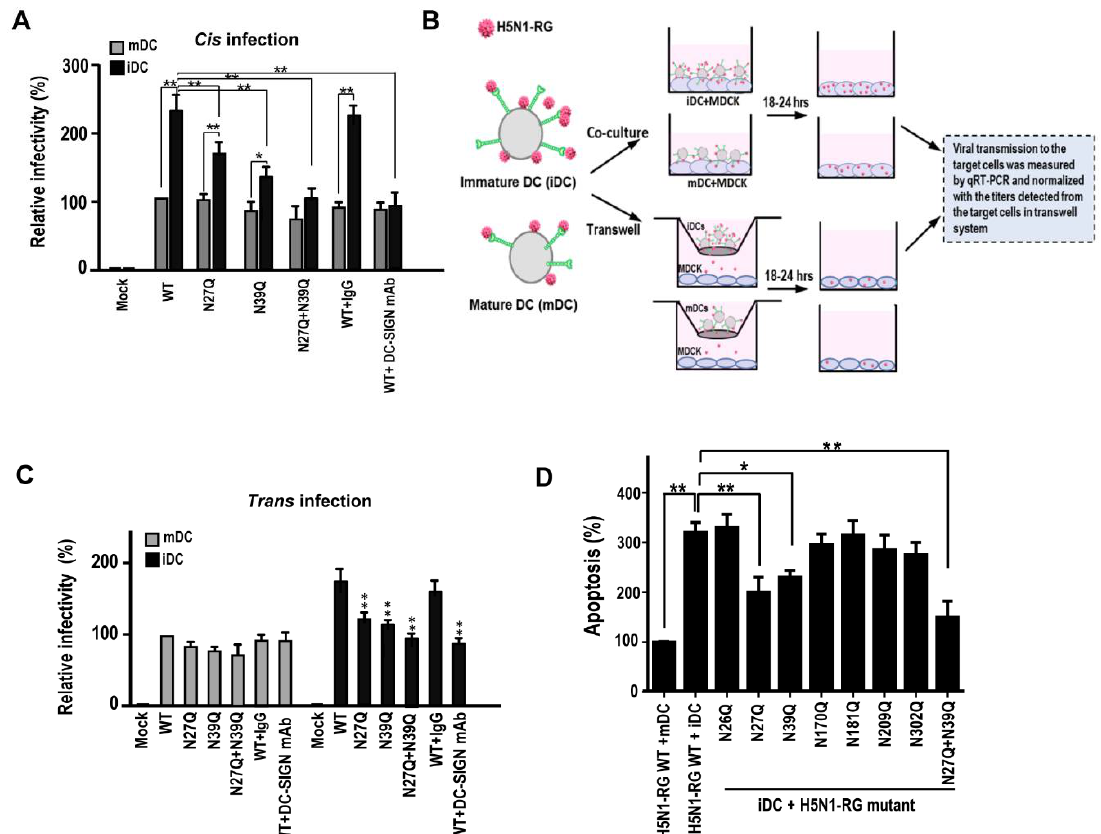
Figure 7. Mutation of 27 and 39 N-glycosylation sites ameliorate DC-SIGN mediated infection in cis and in trans. ( A ) The monocyte derived immature and mature dendritic cells (iDCs and mDCs) were infected with H5N1-RG viruses carrying different N-glycosylation mutations on HA at 37 °C for 48 h and subjected to qRT-PCR analysis. The relative infectivity was determined by viral copies detected in each group and normalized to wild-type virus infected iDCs. ( B ) The scheme of modified conventional capture assay is demonstrated. ( C ) iDCs and mDCs, as the capture cells, were incubated with H5N1-RG viruses carrying different N-glycosylation mutations on HA at 4 °C for 2 h and subjected to co-culture with MDCK cells (target cells) at 37 °C for 18–24 h. After co-culturing, the virions-captured cells (iDCs and mDCs) were removed via of intensive PBS washing (three to five times) and the MDCK cells were subjected to qRT-PCR analysis. The transwell system was used to monitor the virions budding from cis infection (the virions released from captured cells (iDCs and mDCs) are on the upper channel) and further caused MDCK (target cells) (lower channel) infection. The lower channel of MDCK cells receiving the virions from cis infection were also subjected to qRT-PCR. The relative infectivity was determined by using the viral copies detected from co-cultured MDCK and normalized with viral copies of MDCK from transwell system. ( D ) The iDCs and mDCs were infected with H5N1-RG wild-type or N-glycosylation mutants and incubated at 37 °C for 48 h. These infected cells were subjected to apoptosis analyses using Annexin V and propidium iodide staining (WT, wild-type). The significant difference was measured by each N-glycosylation mutant compared to WT group. Representative results are shown. Quantitative data represent the means ± SD of results from at least three independent experiments (WT, wild-type) (* p < 0.05; ** p < 0.01).